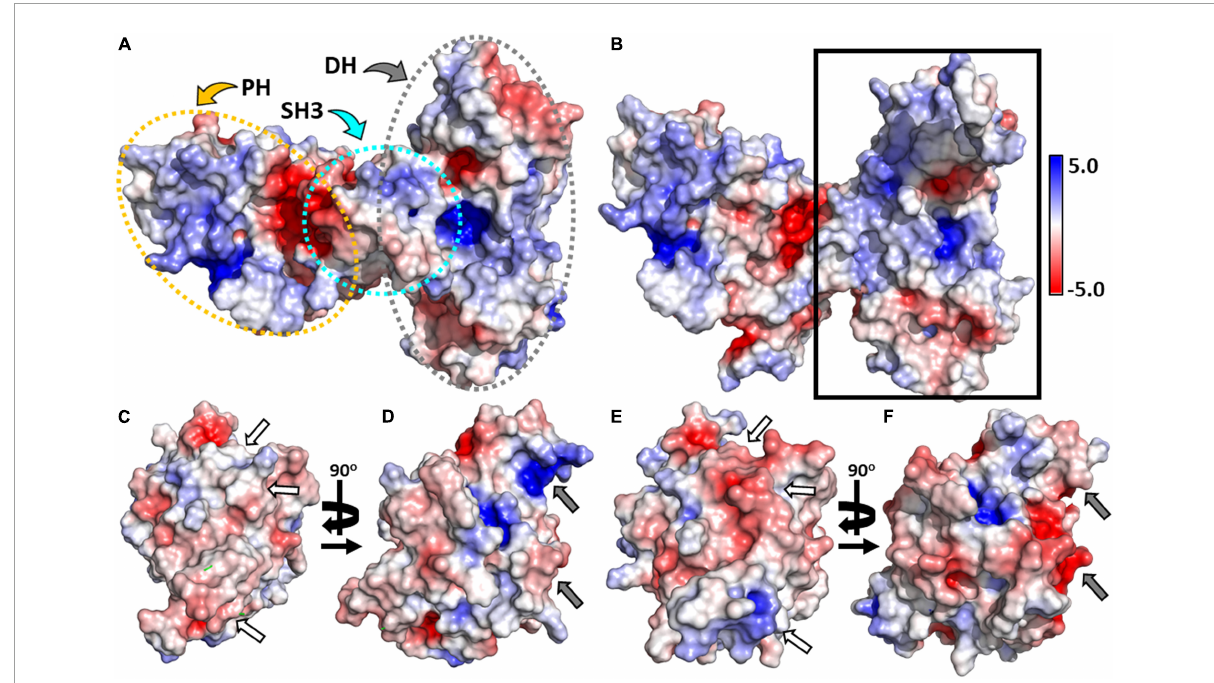
FIGURE6 Electrostatic potentials of CB, Cdc42, and TC10. (A) Surface representations showing the electrostatic potentials of full-length CB (PDB entry 4mt6). The SH3, DH, and PH domains are outlined by dotted ellipsoids shown in cyan, gray, and yellow, respectively. (B) Electrostatic potential of CBSH3 – (PDB entry 2dfk) viewed into the interface region (solid rectangle) of the CBSH3 - -Cdc42 complex with Cdc42 omitted from the calculation. (C,E) Electrostatic potential of Cdc42 showing the interface region of the Cdc42-CBSH3 – complex after rotation by 180 ◦ around the vertical axis (C) and hypothetical CB-TC10 interface region following superimposition of TC10 on Cdc42 (E) . Regions possessing substantial charge differences between Cdc42 (C) and TC10 (E) are emphasized by white arrows. (D,F) Surface charge potential of Cdc42 (D) and TC10 (F) when rotated by 90 ◦ around the vertical axis. Sections having substantial charge differences between Cdc42 (D) and TC10 (F) are highlighted by gray arrows. All electrostatic potentials are represented by isosurfaces contoured at –5.0 k b T/e c (red) or 5.0 k b T/e c (blue),